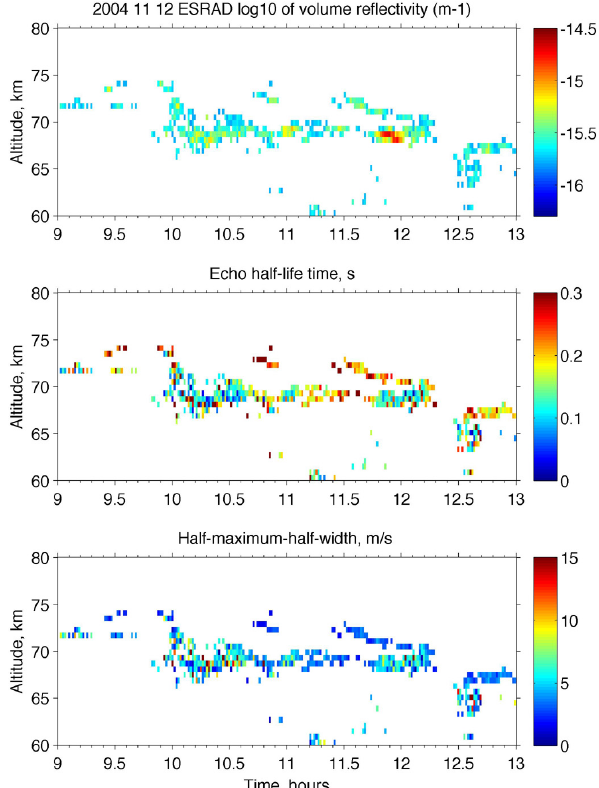
Fig. 7. The altitude-time maps of the ESRAD radar volume re- flectivity (top panel) and the echo half-life time deduced from full correlation analysis (middle panel) and the corresponding half- maximum half-width of power spectra (lower panel) for 12 Novem- ber 2004.